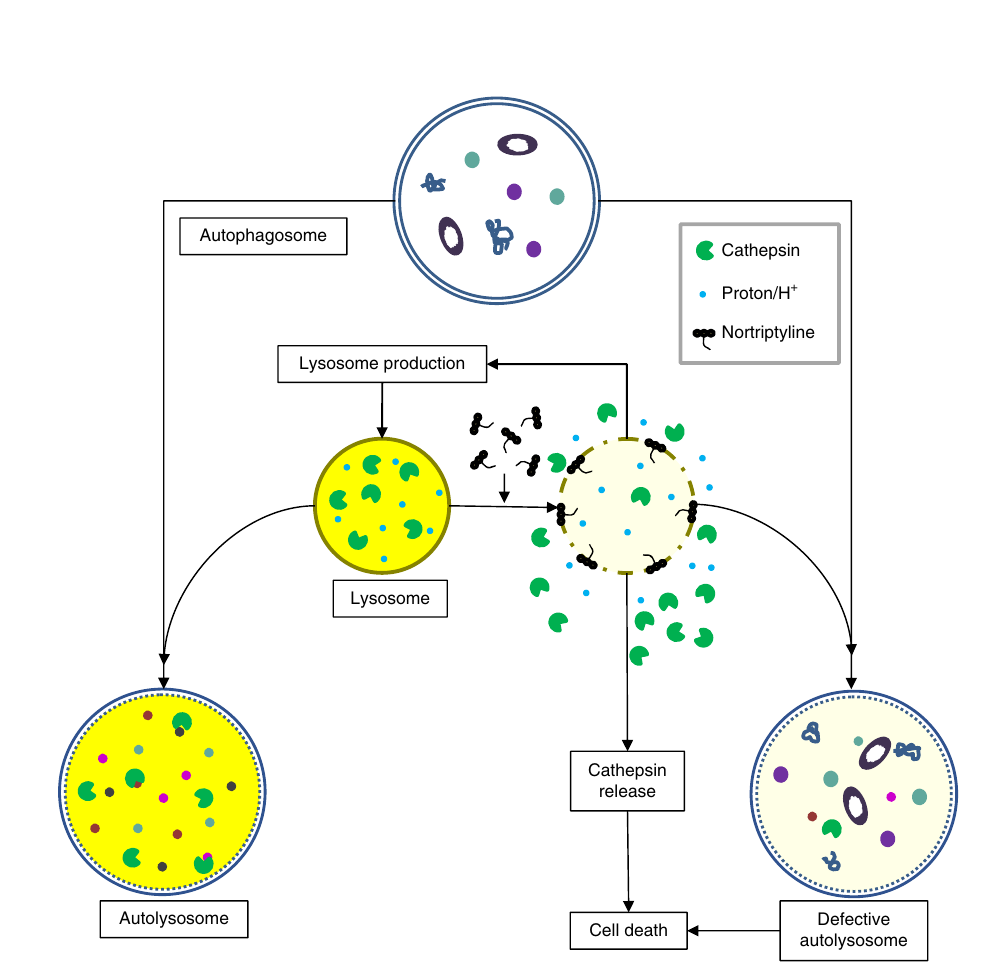
Fig. 9 Model for the cytotoxic effect of nortriptyline on pineoblastoma. In untreated cells (left), autophagosomes with their cargo fuse to lysosomes, which provide digestive enzymes such as cathepsins and high acidic environment (yellow) for their enzymatic activity, to form functional autolysosomes where the cargo is degraded. Both mouse and human pineoblastomas are highly sensitive to the cationic amphiphilic (CAD) tricyclic drug nortriptyline, which disrupts the lysosomes leading to release of protons and cathepsins, and to accumulation of non-functional autolysosomes that fail to degrade their payload, ultimately leading to cell demise (right). Tumor cells utilize autophagy as an escape mechanism to evade anti-neoplastic cytotoxic drugs, and, in accordance, nortriptyline effectively cooperates with gemcitabine to suppress